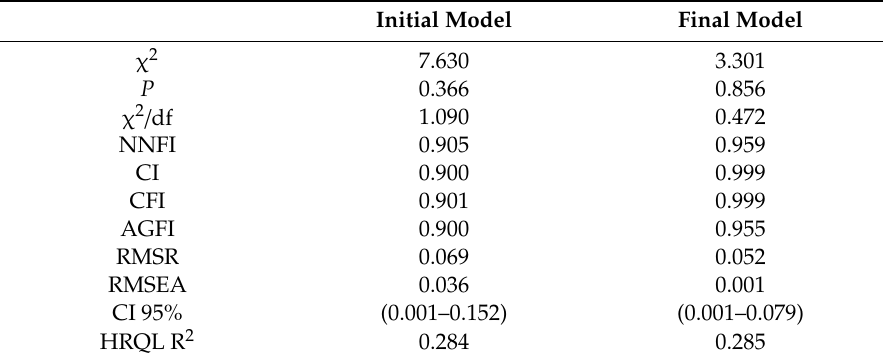
Table 3. Adjustment rates of the tested multivariate